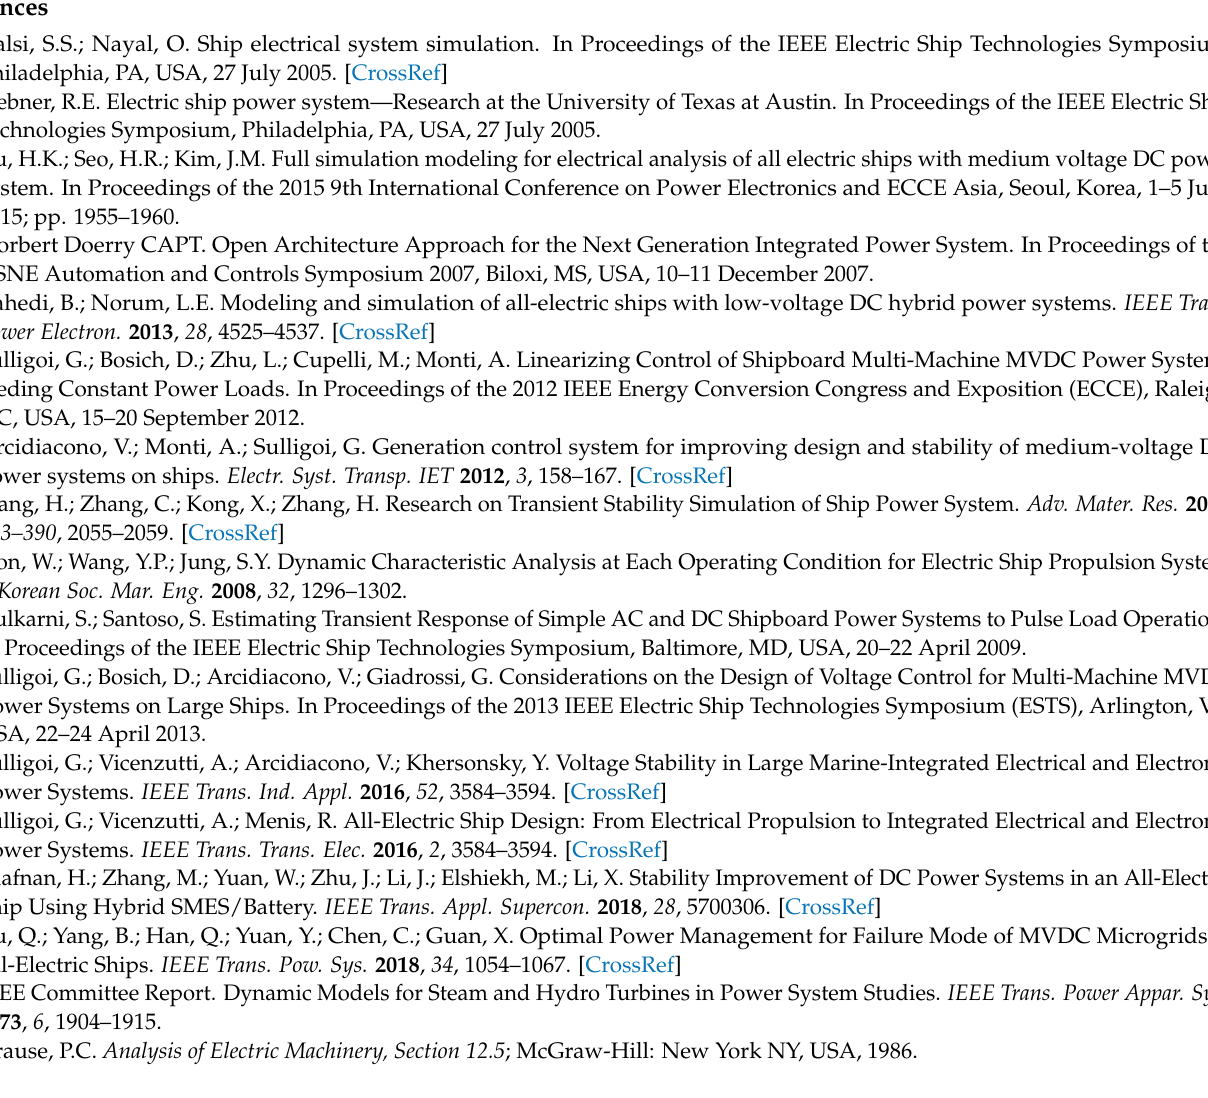
Figure A6. Example of PMS operation in prime mover trip scenario.